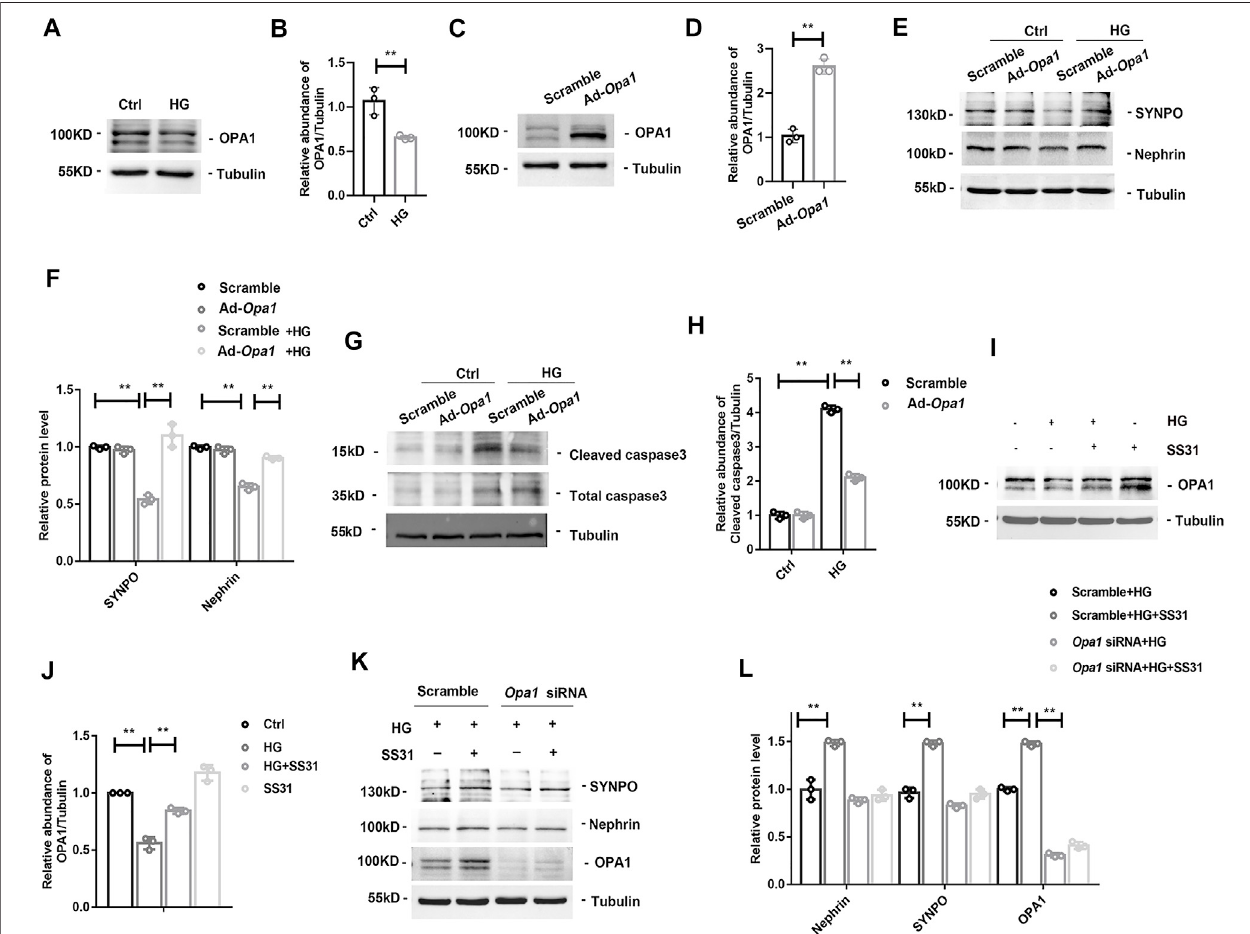
FIGURE5| OPA1-dependentprotectiveeffectofSS31. (A,B) WesternblotanalysisshowingOPA1expressionofpodocytestreatedwithHG(30 mM)for24H.n (cid:1) 3. ** p (cid:1) 0.005. (C,D) Western blot analysis of the proteins of OPA1 in podocyte with Adenovirus-mediated Opa1 overexpression (Ad- Opa1 ). n (cid:1) 3. ** p < 0.0018). (E,F) Western blot analysis for SYNPO and Nephrin expression in podocytes with or without overexpression of OPA1. Podocytes were transfected with adenvirus Scramble andAd- Opa1 for24 h,cellswereincubatedwithorwithoutHG(30 mM)foranother24 hn (cid:1) 3,** p < 0.01:forSYNPO: p (cid:1) 0.004(ScramblevsScramble+HG), p (cid:1) 0.003(Scramble +HG vs Ad- Opa1 +HG); for Nephrin, p (cid:1) 0.004(Scramblevs Scramble + HG), p (cid:1) 0.003(Scramble +HG vs Ad- Opa1 +HG). (G,H) Westernblot analysis showing cleaved caspase3 and total caspase3 expression in HG treated podocyte with or without Ad- Opa1 transfection. n (cid:1) 3, ** p < 0.01: p < 0.001(Ctrl vs HG), p (cid:1) 0.002(HG + Scramble vs HG + Ad- Opa1 ). (I,J) Western blot analysis showing podocyte OPA1 expression in podocytes cultured with high glucose in the presence or absence of SS31. n (cid:1) 3, ** p < 0.01: p (cid:1) 0.004(Ctrl vs HG), p (cid:1) 0.006(HG vs HG + ss31), p (cid:1) 0.01(Ctrl vs SS31). (K,L) Western blot analysis for SYNPO, Nephrin and OPA1expressioninSS31treated-podocytesculturedwithHGwithorwithout Opa1 siRNAtransfection.Podocytesweretransfectedwithscrambleand Opa1 siRNAfor 24 h. Then, cells were incubated with HG (30 mM) in the presence or absence of SS31 (100 nM) for another 24 h. n (cid:1) 3. ** p < 0.01: for Nephrin, p (cid:1) 0.004(Scramble + HG vs Scramble + HG + ss31); for SYNPO, p (cid:1) 0.002(Scramble + HG vs Scramble + HG + ss31); for OPA1, p (cid:1) 0.002(Scramble + HG vs Scramble + HG + ss31), p < 0.001(Scramble + HG + ss31 vs Opa1 siRNA + HG).